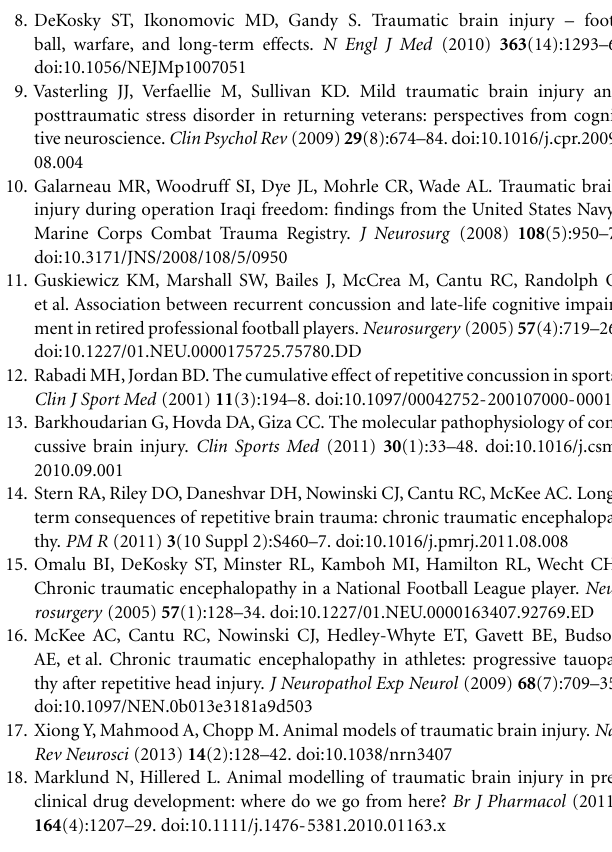
with an antibody against p-CREB. Representative images were taken from amygdala (A) and hippocampus (C) , and p-CREB immunoreactivity (B,D) was quantified as percentage of area occupied. Scale bar in (A,C) = 20 µ m. n = 8 (sham) and 15 (mTBI) mice/group. Mean ± SEM. * P < 0.05, by t